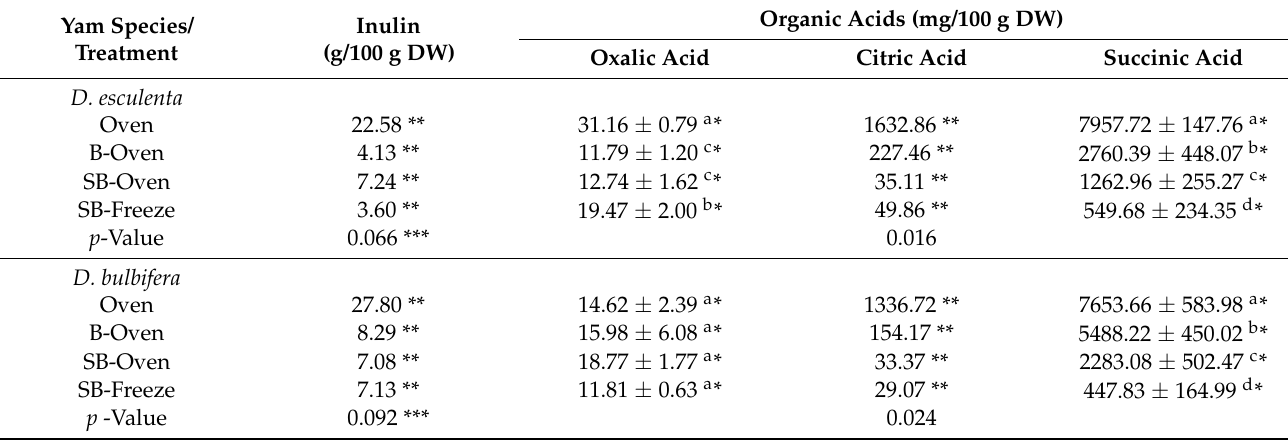
Table 5. Inulin and organic acids compositions of yam flour prepared with different processing techniques. Yam Species/